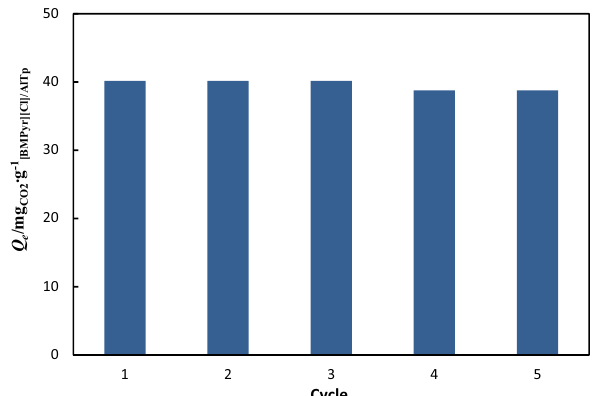
Figure 9. The CO 2 absorption capacity of [BMPyr][Cl]/AlTp at p = 1 bar and T = 298.15 K in five regeneration